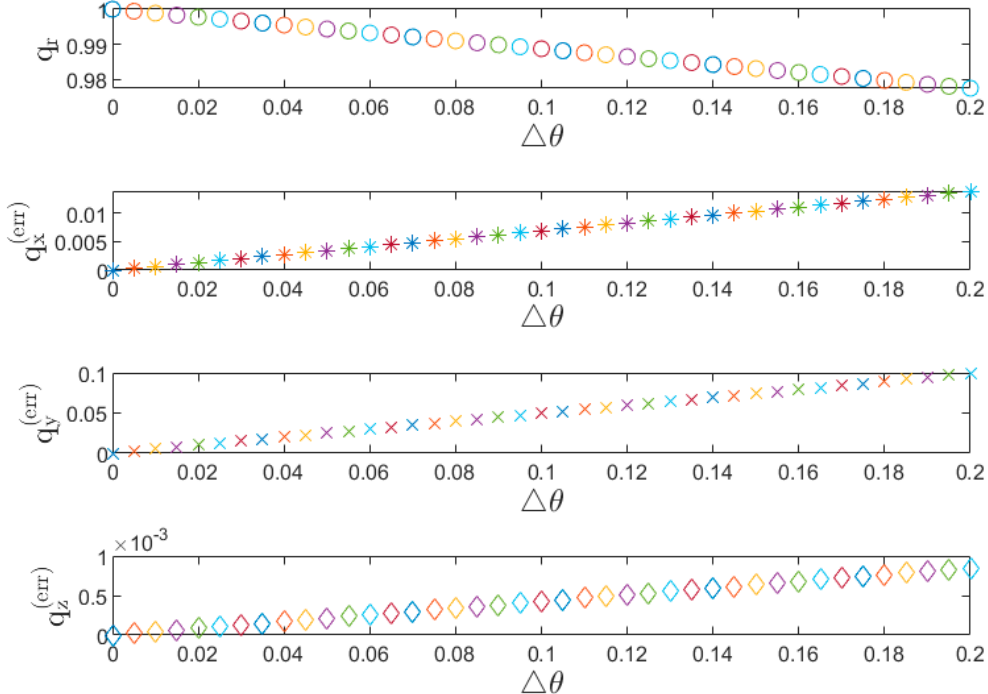
Figure 17. The scalar part and the vector part of the quaternion error for a small rotation of measurement error of pitch angle.